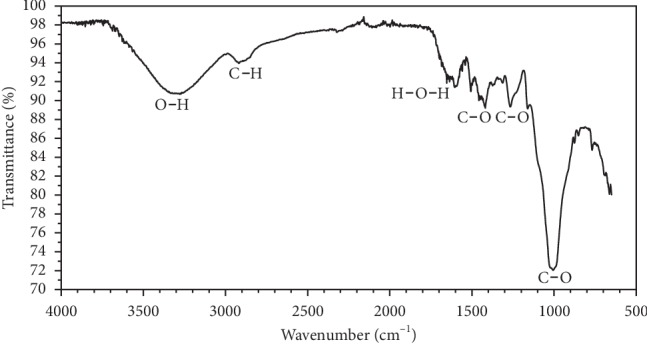
FTIR spectra of raw PO fibers.